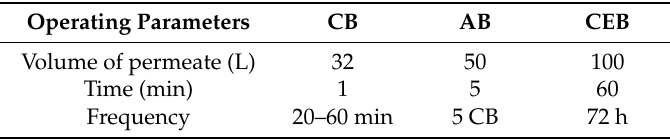
Table 3. Operating parameters of membrane